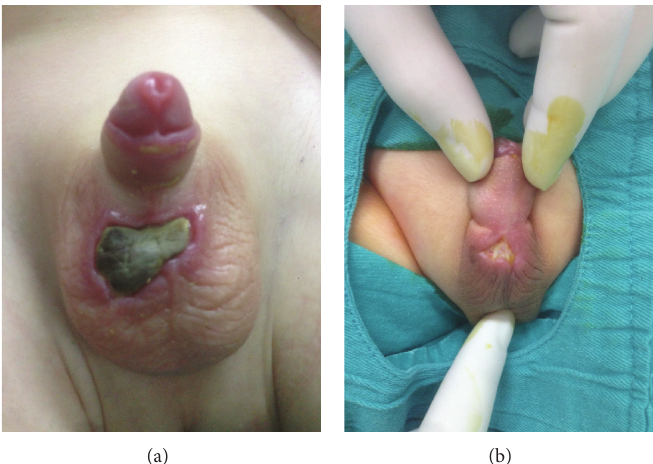
Figure 1: (a) Skin necrosis with a crusty wound just below the penoscrotal junction following lidocaine injection in case 1. (b) Skin necrosis with a fallen shell wound just below the penoscrotal junction following lidocaine injection in case 2.